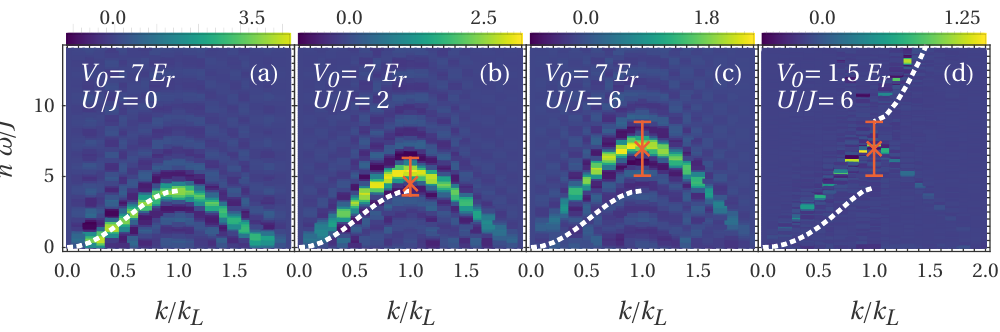
Figure 2: Dynamic structure factor S ( k , ω ) from tVMC simulations for bosons in an = 7 E optical lattice of amplitude V and equivalent BHM parameter U / J = 0;2;6 r 0 = 1.5 E (panels (a)–(c)), and V with U / J = 6 (panel (d)). The dashed white lines r 0 show the dispersion of non-interacting particles ( U = 0) for the given value of V obtained from band structure calculations. The red bar indicates the spread of the multipeak feature in S ( k , ω ) of Ref. [ 39 ]